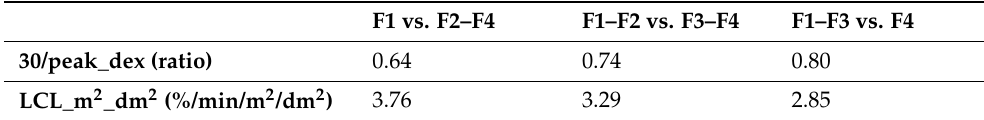
Figure 2. Correlation between the most significant scintigraphic parameters and liver fibrosis stages. ( A ) Direct positive correlation between liver excretion rate (30/peak) and liver fibrosis–tracer retention increases with increasing liver fibrosis. ( B ) Direct negative correlation between liver clearance (LCL) and liver fibrosis–tracer clearance decreases as liver fibrosis progress. Table 7. Threshold of the most robust threshold values through liver stages.